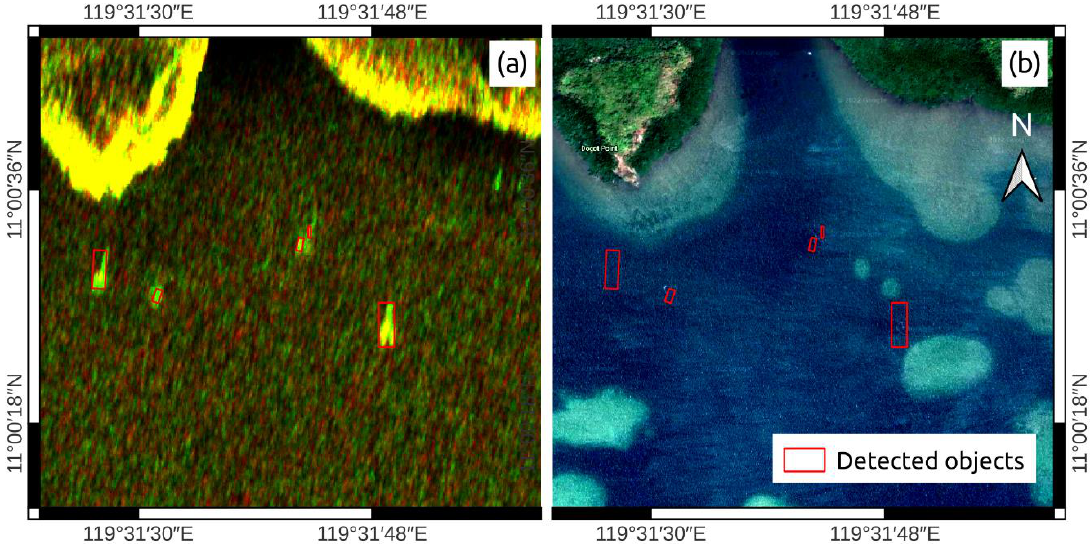
Figure 6. Detection of static objects in SAR data: ( a ) RGB composite image with VV polarisation given in red and VH polarisation in green; ( b ) Google Earth high-resolution satellite image. The contours of detected objects are outlined in red.